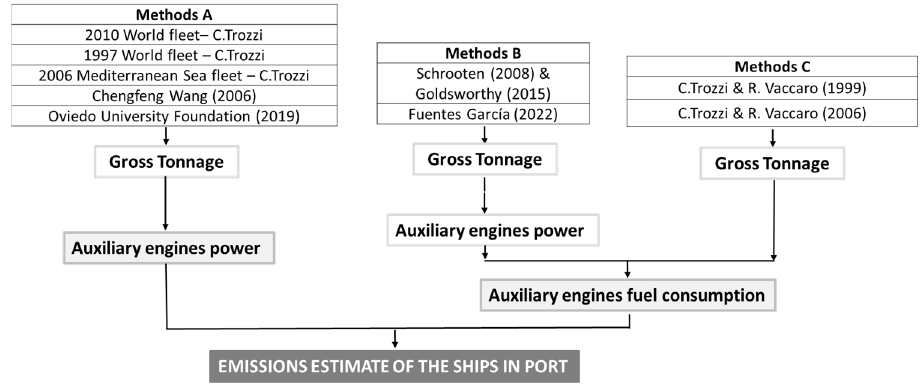
Figure 1. Methods to estimate emissions from ships in port [5,26–36].